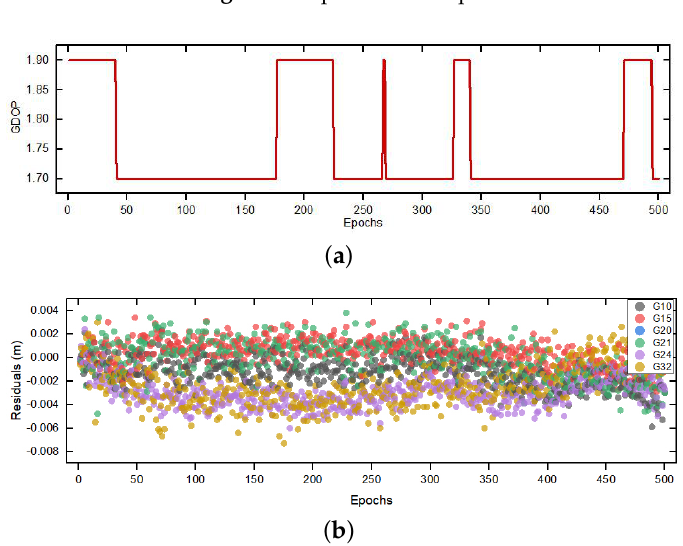
Figure 5. GDOP and Measurement residuals during the sampling periods ( a ) GDOP value. ( b ) The measurement residuals of carrier